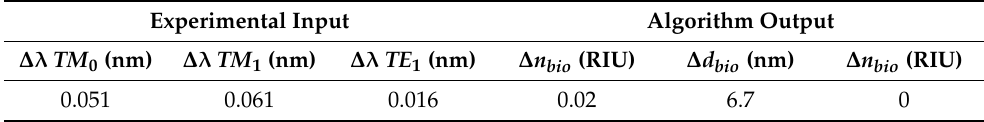
Table 3. Experimental Input and Algorithm Output for Yeast.